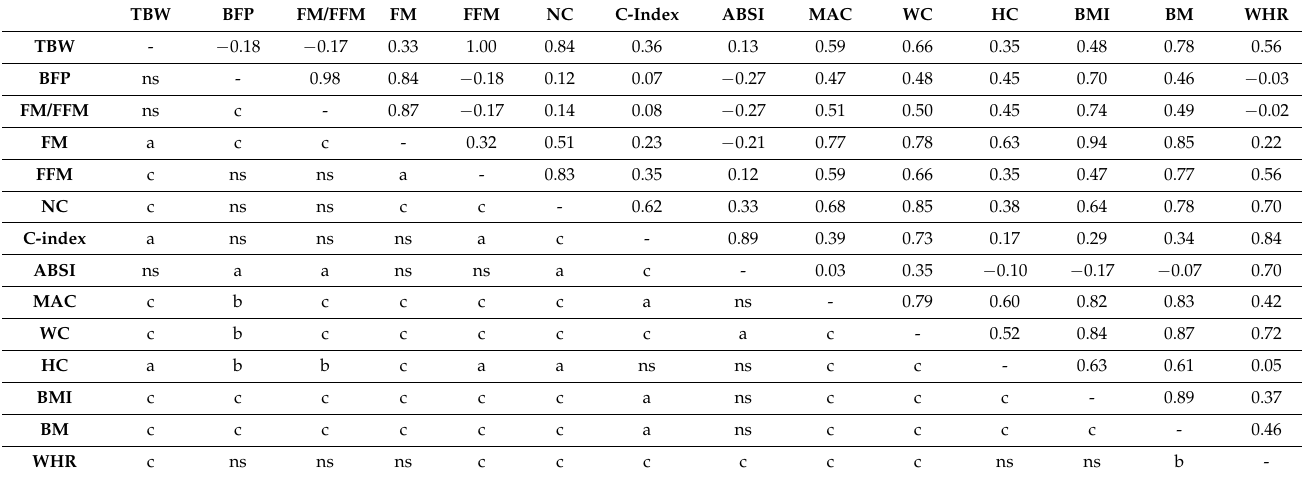
Table 2. Pearson’s correlations of the studied